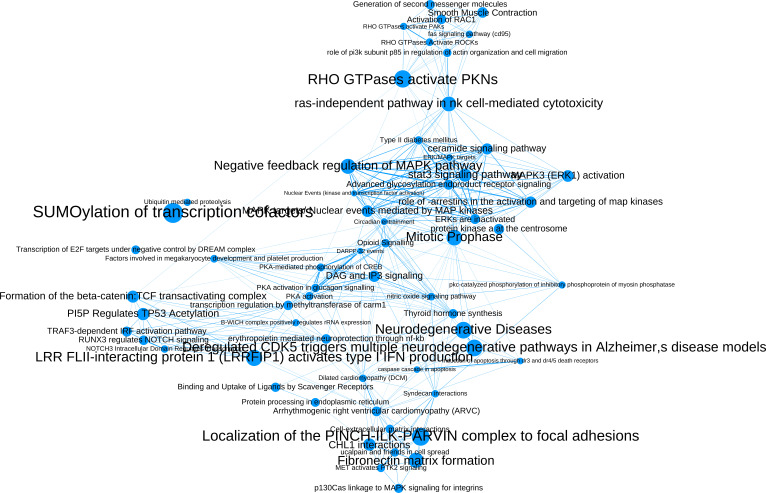
The network of significantly enriched pathways of the top-ranked (empirical p-value<0.01) candidates prioritized by the addition of the M(IL-4) co-abundance network to the PPI network.Node size indicates the significance of each pathway in –log(q-value) and edge thickness represents the overlap between the genes of the two pathways they connect, measured in terms of the Jaccard index.